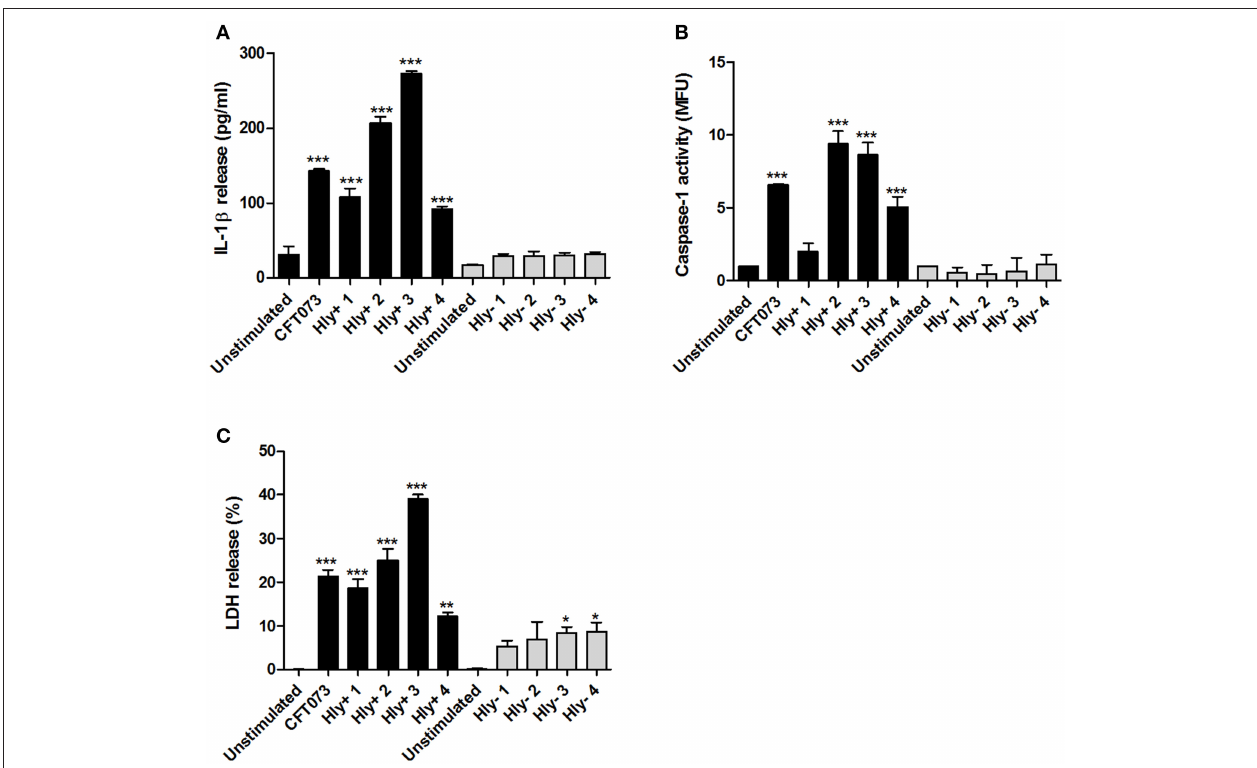
FIGURE 4 | IL-1 β release, caspase-1 activity and LDH release in α -hemolysin positive or negative clinical UPEC isolates. The bladder epithelial cell line 5637 was infected with CFT073 and four α -hemolysin positive UPEC isolates (Hly + ) and four α -hemolysin negative UPEC isolates (Hly-) for 6h at MOI 10. IL-1 β release (A) , caspase-1 activity (B) and LDH release (C) were evaluated. LDH release is presented as % of total LDH. Data are presented as mean ± SEM ( n = 3 independent experiments). Asterisks denote statistical significance compared to respective unstimulated control (* p < 0.05, ** p < 0.01, *** p <